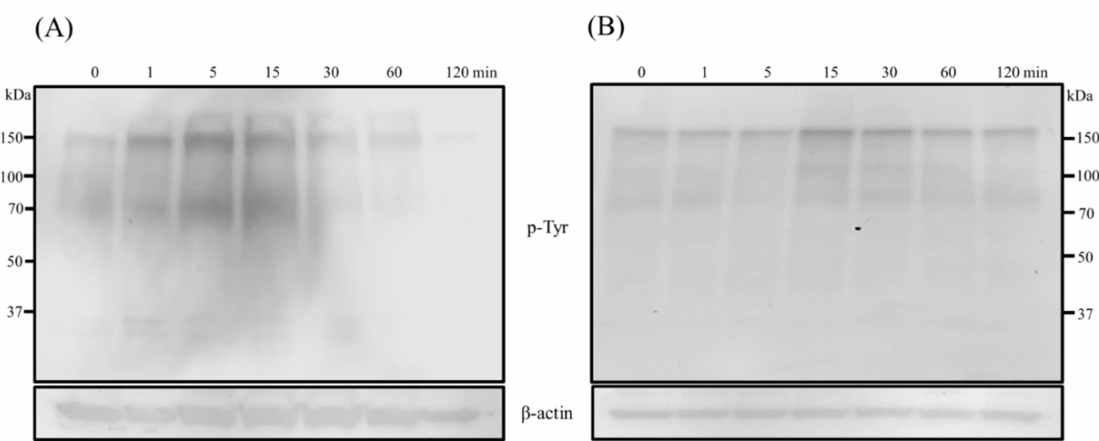
Figure 5. Protein tyrosine phosphorylation levels of ( A ) hTCEpi cells and ( B ) SFs after treatment with BMP7 (100 ng/mL) at different time points. Cells were treated with BMP7 and the total cell lysates were collected at time points 1, 5, 15, 30, 60 and 120 min, and subjected to immunoblot analysis. An increased total protein tyrosine phosphorylation (lasted until 30–60 min approximately) following BMP7 stimulation was evident. Amounts of the β -actin protein levels which were detected with an anti- β -actin antibody served as a loading control. One representative immunoblot of at least three independent experiments is